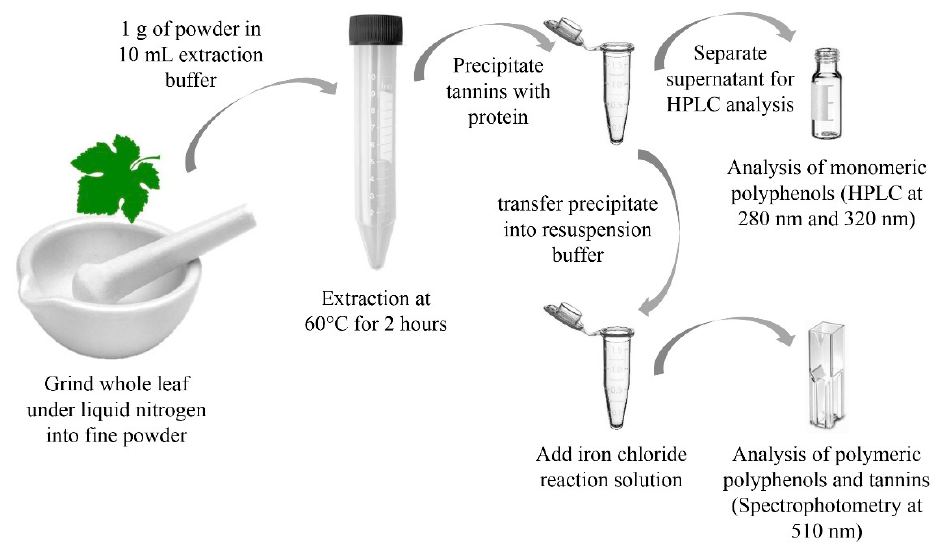
Figure 1. Proposed procedure to extract and separate monomeric and polymeric polyphenols from leaf tissue in grapevines.